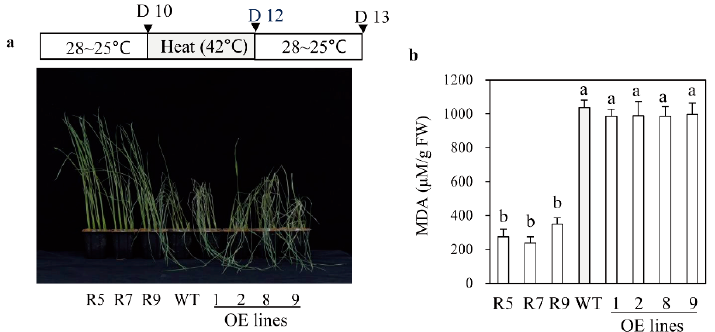
Figure 8. Response to heat treatment. ( a ) Seedlings after recovery from heat stress. ( b ) MDA content. Ten-day-old rice seedlings were challenged with heat stress at 42°C for 2 days and then allowed to recover for 1 day. Different letters indicate significant differences as determined by a post-hoc Tukey’s HSD test at p < 0.05.